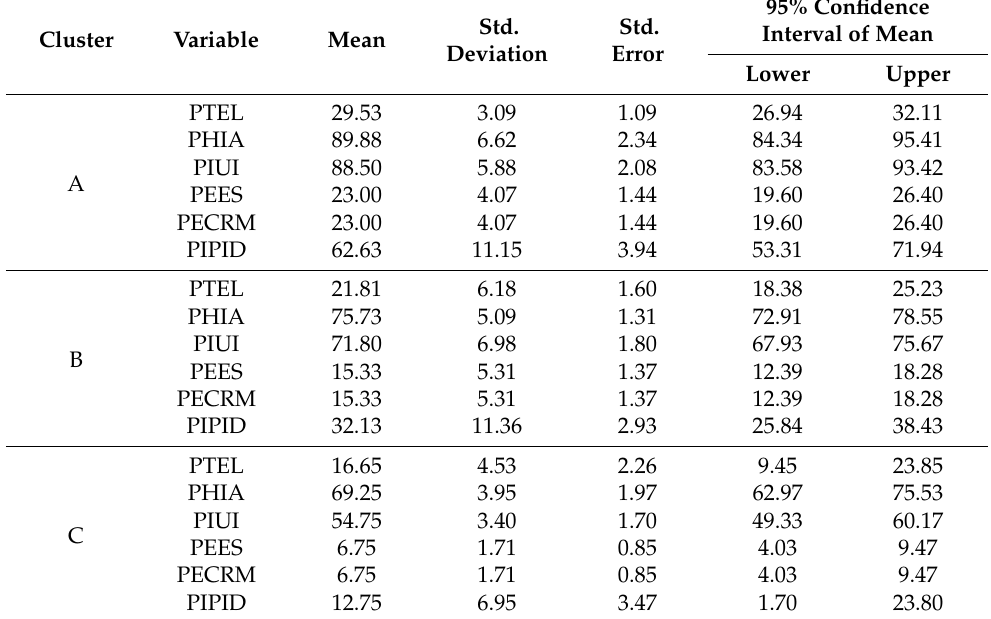
Table 6. Average characteristics of groups by level of development of Internet purchases in 2012.